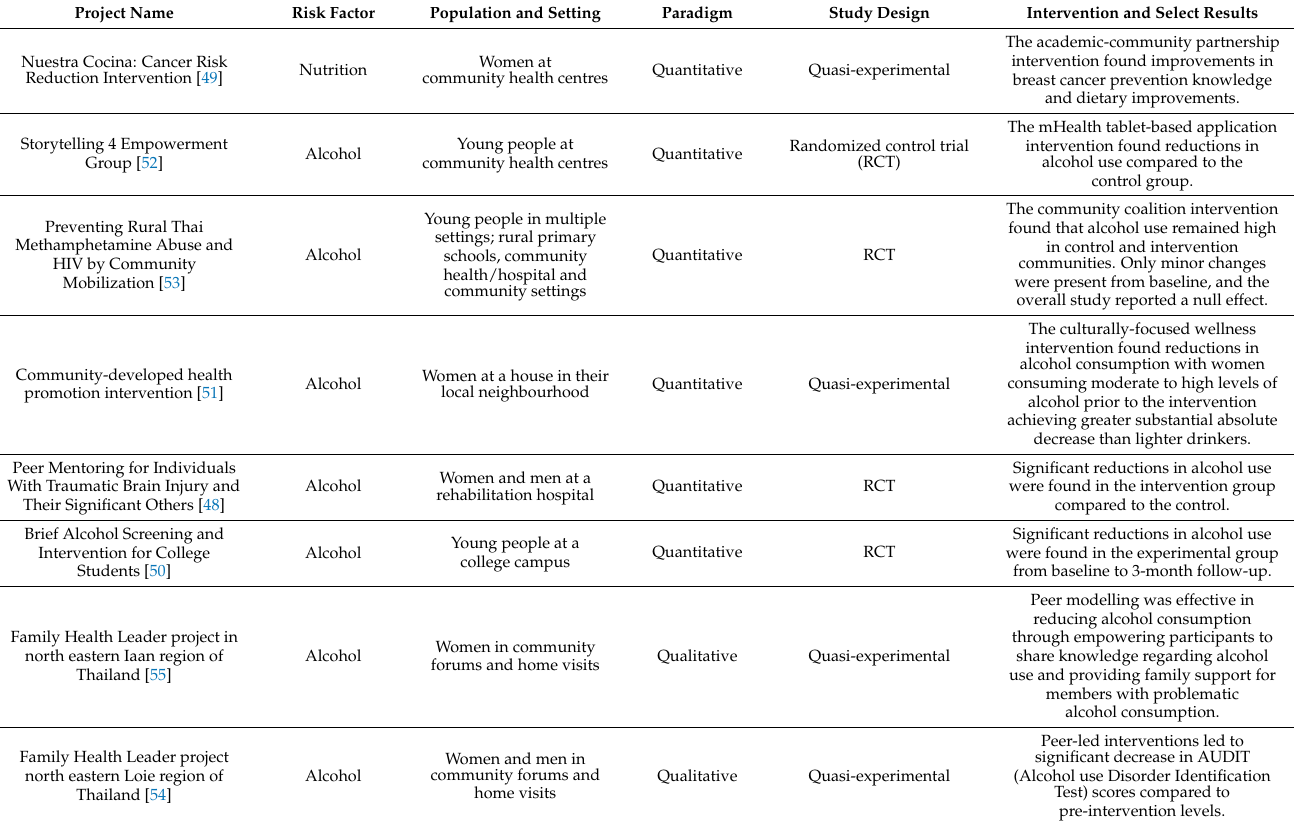
Table 2. Characteristics of included